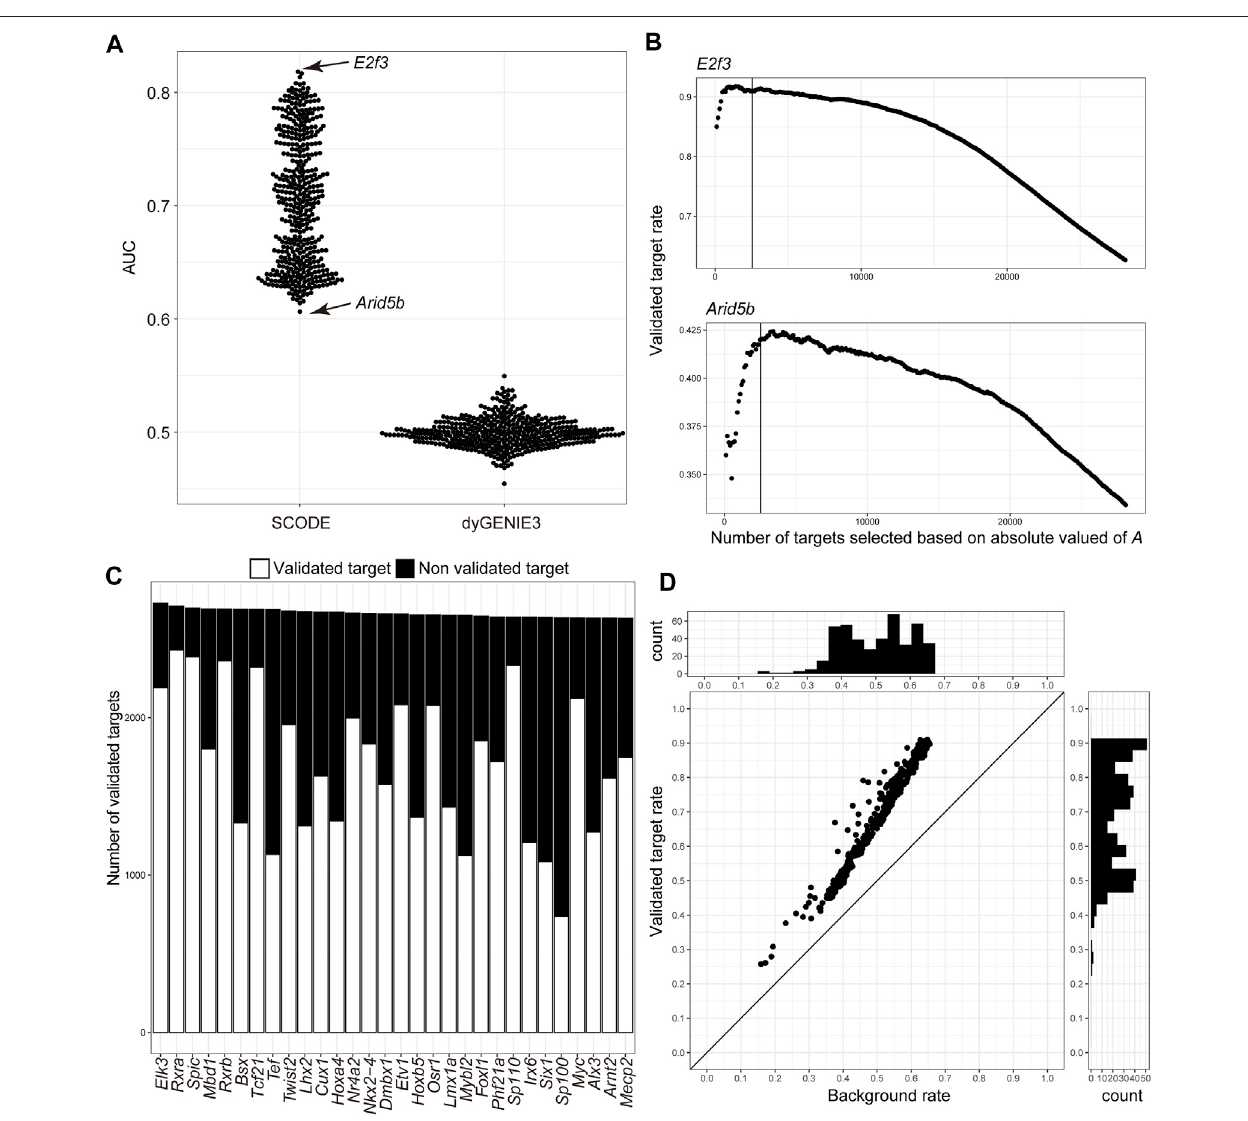
FIGURE 3 | Validation of the inferred regulatory network of transcription factors with the TF2DNA database. (A) Scatter plot of area under the curve (AUC) target selection for each transcription factor (TF) based on the absolute values of A inferred using SCODE and weight.matrix inferred using dyGENIE3. (B) Scatter plots of the validatedinferredtargetgenerateofE2f3andArid5bintheTF2DNAdatabase.DownstreamgenesofTFswereselectedbasedontheabsolutevaluesofAindecreasing order. Solid lines indicate genes at the thresholds. (C) Bar graph of validated and non-validated downstream genes of each TF in the TF2DNA database, in decreasing order of the total number of inferred downstream genes. Only the top 30 TFs are shown. (D) Scatter plot of the validated target gene rate of the inferred downstream genes of TFj and the background rate of target genes in the TF2DNA database. Histograms show the distribution of validated target gene rates of inferred downstream genes and the background rates of downstream genes in the TF2DNA database.